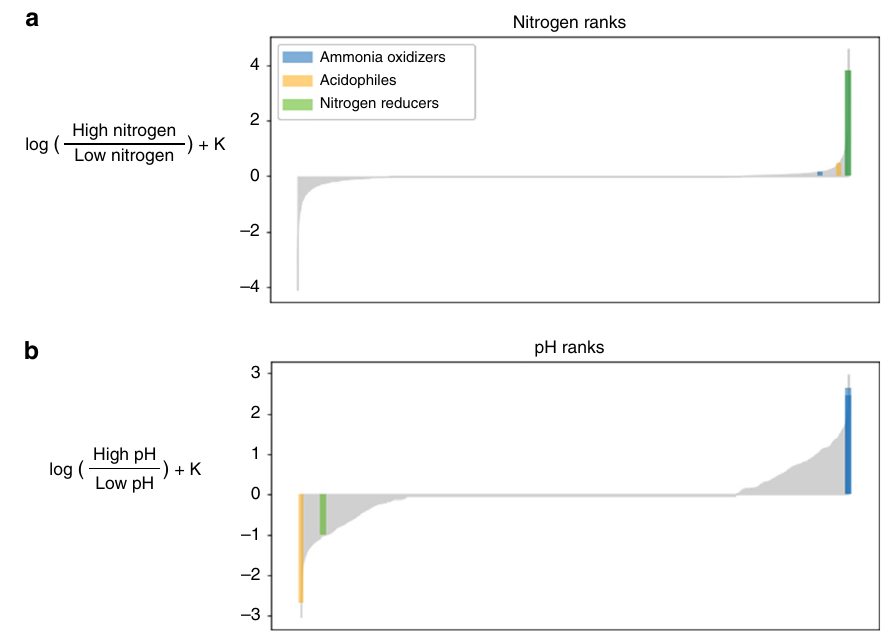
Fig. 4 DR analysis of the Central Park dataset. a Microbes ranked with respect to their association with nitrogen. b Microbes ranked with respect to their association with pH. Putative hits against an acidophile, an ammonia oxidizer and a nitrogen reducer are